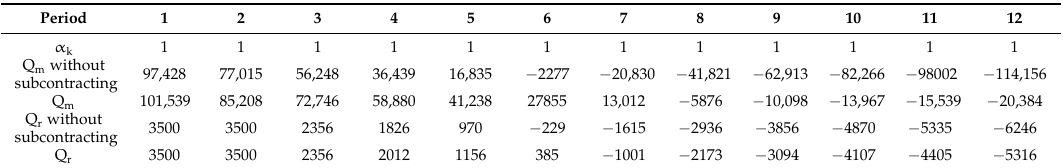
Table 10. Amount of emitted carbon during the different process with Q cm = 118,000 and Q cr = 3500. Period 1